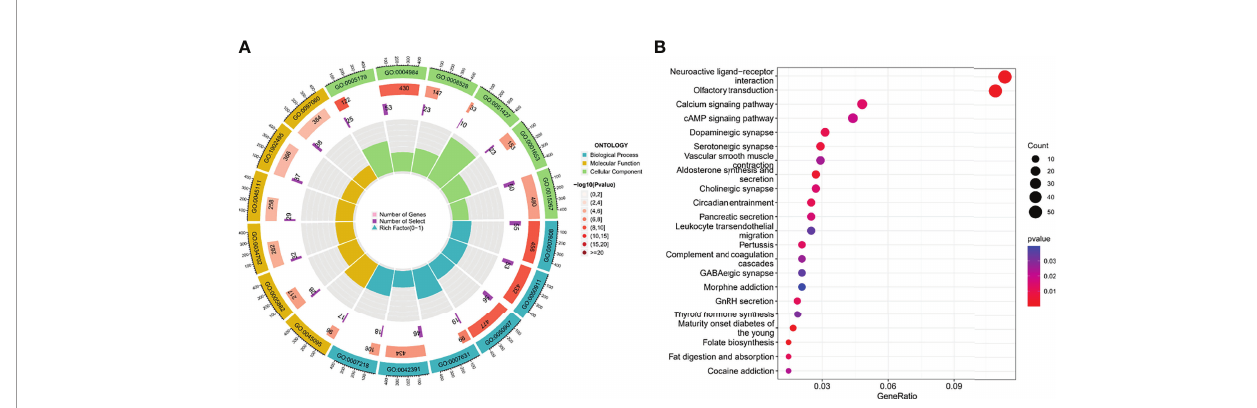
FIGURE 5 | The functional enrichment analysis of cluster-associated DEGs. (A, B) GO and KEGG